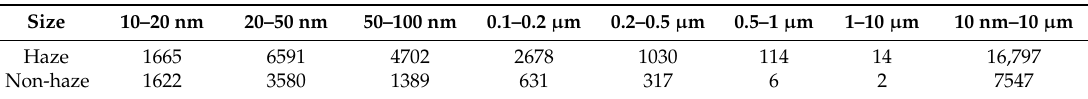
Table 3. Average number concentration of particles in different size fractions on haze and non-haze days (unit/cm 3 ).